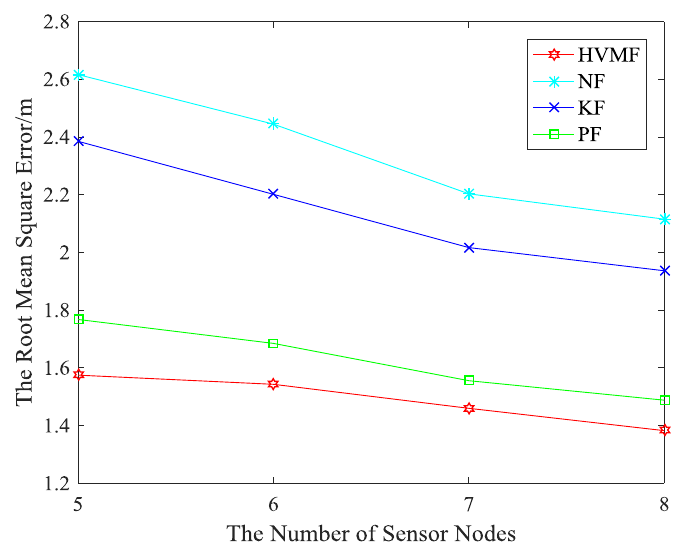
Figure 17. The number of beacon nodes versus RMSE.